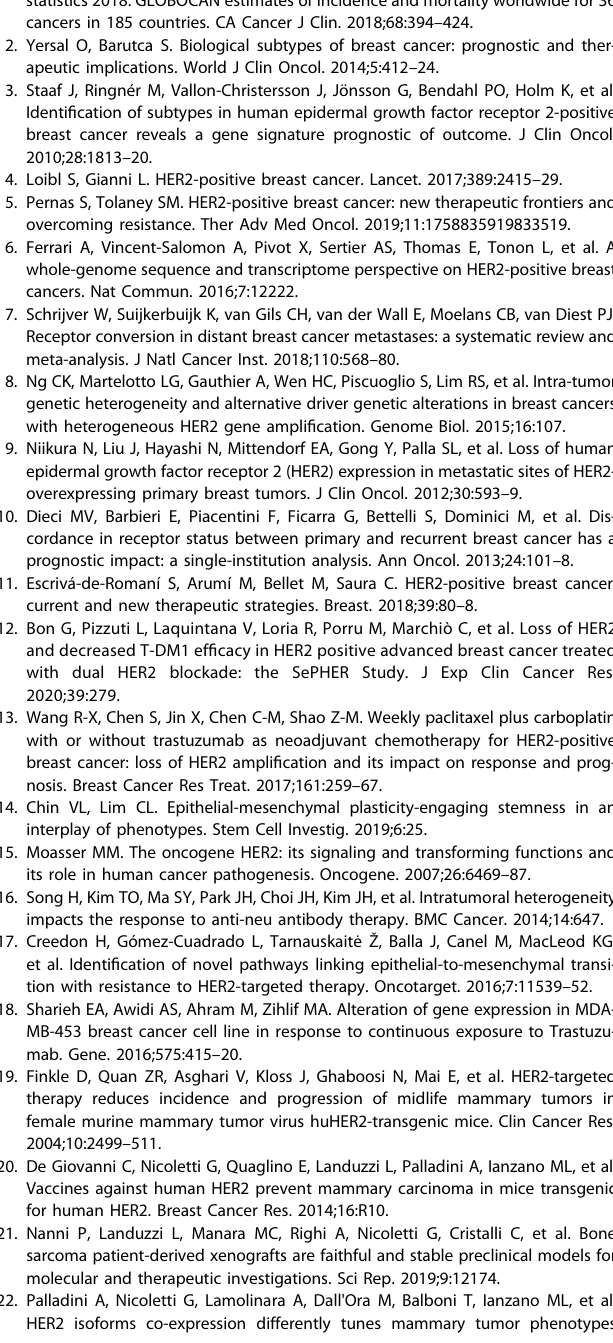
Fig. 7 Targeting PDGFR-B in vivo (B-C) and in vitro (D-G). A Expression level of PDGFR-B by cyto fl uorimetric analysis. Pro fi les: gray, secondary antibody; blue, MamBo89HER2 stable cell line; black, MamBo43HER2 labile cell line; green, MamBo38HER2 loss cell line; red, trastuzumab- treated MamBo43HER2 labile cell line (MamBo43HER2 labile TRT). B Effect of sunitinib on MamBo43HER2 labile tumor growth. Sunitinib signi fi cantly reduced tumor growth from the 37 th day after cell injection onward, p < 0.05, at least, by unpaired t test with Welch ’ s correction. C Effect of sunitinib on MamBo38HER2 loss tumor growth. Sunitinib signi fi cantly reduced tumor growth from the 11 th day after cell injection onward, p < 0.05, at least, by unpaired t test with Welch ’ s correction. In B , C untreated mice (black square, MamBo43HER2 labile or green square, MamBo38HER2 loss ) or 60 mg/Kg sunitinib-treated mice (orange circle). Data shown are the mean and SEM from 4 – 5 mice per group. D – G Effect of sunitinib (5 μ M) on MamBo38HER2 loss . D Mammosphere formation assay. Data shown are the mean and SEM, n = 2 – 4 for each group; p < 0.001, sunitinib vs untreated or vehicle by Student ’ s t-test. E Wound-healing assay. Data shown are the mean and SEM, n = 6 – 8 for each sunitinib-treated group. p < 0.001, vs untreated or vehicle by Student ’ s t-test. F IL6 production detected by ELISA. G Western blotting analysis for STAT3 and pSTAT3 on cells treated with